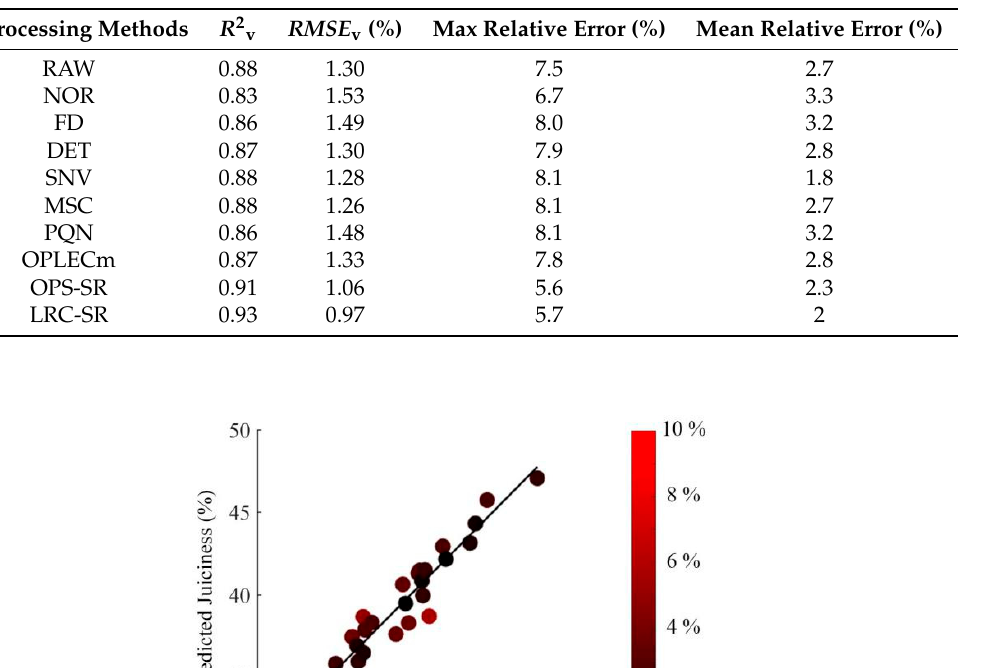
Table 3. The partial least squares regression modeling results of the external verification for pear juiciness based on the characteristic wavelengths using di ff erent preprocessing spectra. R 2 v represents the determination coe ffi cient of external validation, RMSE v represents the root mean square error of external verification, a.u. stands for arbitrary unit.